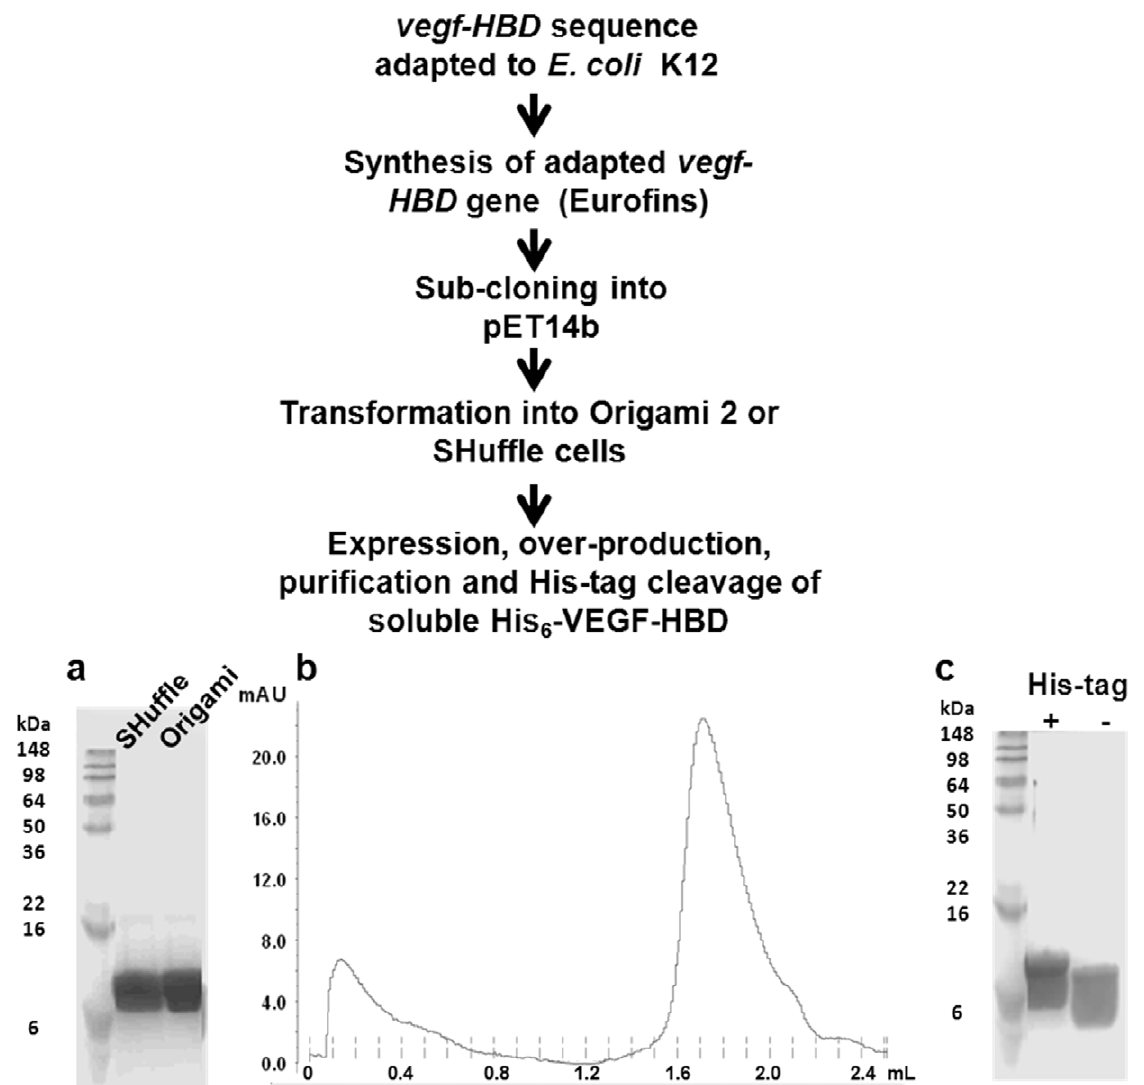
Figure 1. Steps to producing soluble VEGF-A 165 -HBD. The gene sequence encoding the VEGF-A 165 -HBD protein was adapted to that of E. coli K12 genome and the 5 9 and 3 9 restriction enzyme sequences of Nde I and Xho I were incorporated, respectively. The gene was then synthesised and subcloned into pET14b by Eurofins. The recombinant plasmid was transformed into Origami 2 and SHuffle cells and tested for expression. (a) VEGF- A 165 -HBD was over-produced and purified from both cell types; however, VEGF-A 165 -HBD produced from SHuffle cells showed a greater yield of presumably folded protein based on absorbance at 280 nm which was solely dependent on cysteines having formed cystines (disulphide bonds). Even though relative staining of the protein bands on the gel would suggest that the two protein samples are at similar concentrations, absorbance measurements at 280 nm indicate that the sample from SHuffle cells had a concentration of 3.1 mg/ml of disulphide-bonds-containing protein compared to 1.7 mg/ml in Origami cells. (b) VEGF-A 165 -HBD protein from SHuffle cells was further purified on a preparative Superdex 75 size exclusion column. (c) His 6 -tag was successfully removed using thrombin and resulting VEGF-A 165 -HBD retained solubility and stability as assessed by absence of precipitation and further proteolytic cleavage. albumin (BSA), followed by addition of 1 nM biotinylated (bt) stopping solutions and signal intensity quantified using a Tecan VEGF-A 165 (R&D Systems). DU145 cells used in these assays do Genios plate reader at A450 nm with a reference wavelength of not express other VEGF receptors [21] and the levels of endogenously expressed NRP1 are too low to reliably measure binding of bt-VEGF-A 165 to endogenous NRP1. After 2 h of incubation at room temperature, the plates were washed three times with phosphate buffered saline (PBS). The bt-VEGF-A 165 bound to Ad.NRP1 was detected by incubation with streptavidin- horseradish peroxidase conjugates for 30 min. Cells were then washed 3 times in PBS before detection with substrate reagent (R&D Systems) for 20 min. The reaction was stopped with